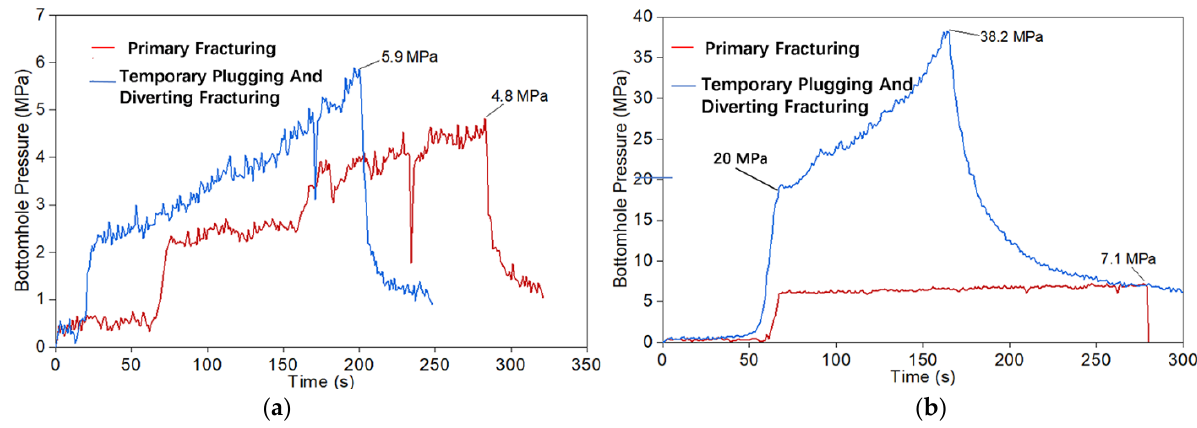
Figure 8. Pressure curves for coal samples 4# and 5#: ( a ) pressure curves of sample 4#; ( b ) pressure curves of sample 5#.